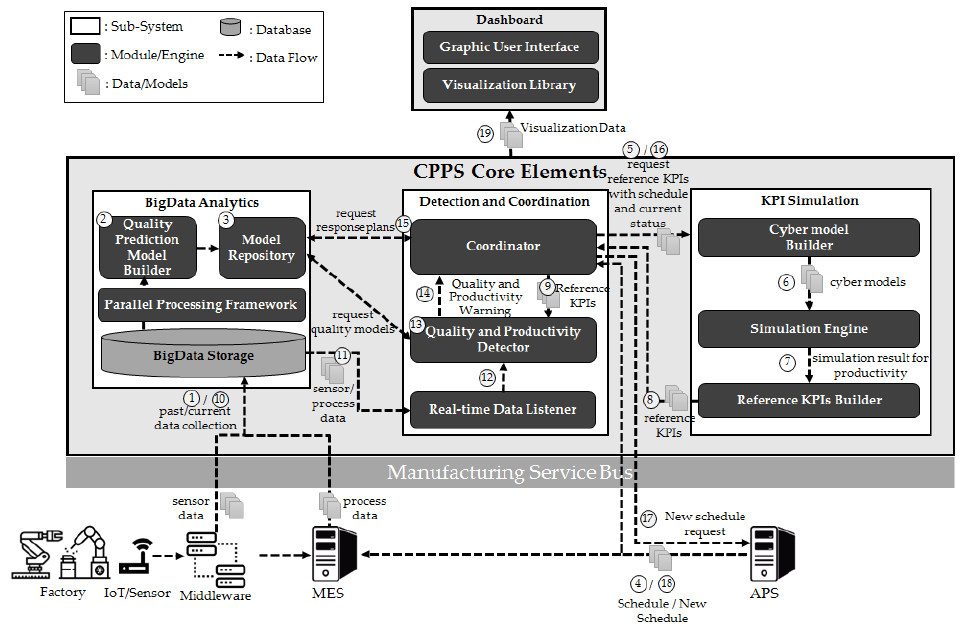
Figure 1. Cyber-physical production system (CPPS) architecture framework.